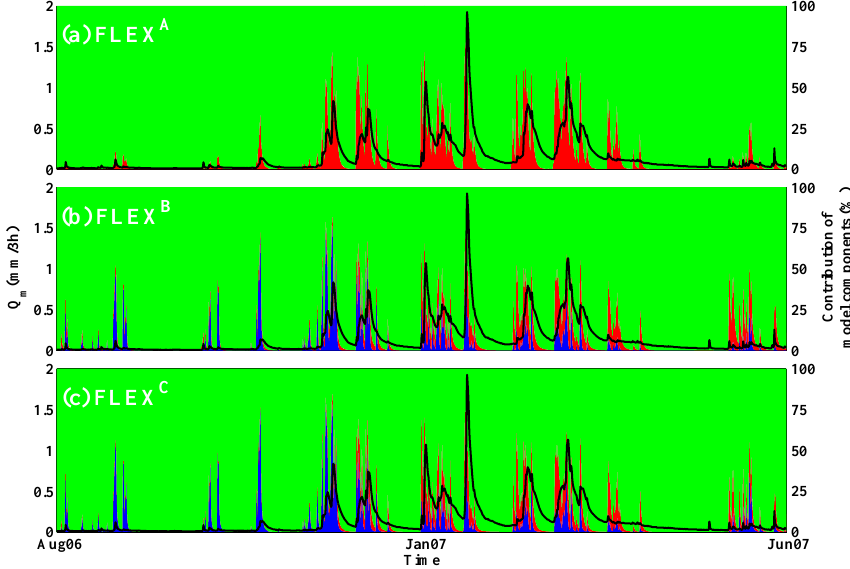
Figure 6. Comparison between mean proportions of Pareto members for model components of the three model setups in part of the validation periods (August 2006–June 2007) (a) FLEX A , (b) FLEX B , and (c) FLEX C . The green color indicates the relative contribution of the slow reservoir for the three different models. Red indicates relative contribution from the fast components, i.e., fast reservoir in FLEX A , fast reservoir of the remainder of the catchment in FLEX B and fast reservoir of hillslope of FLEX C . The blue color indicates the relative contribution of fast wetland component of FLEX B and FLEX C